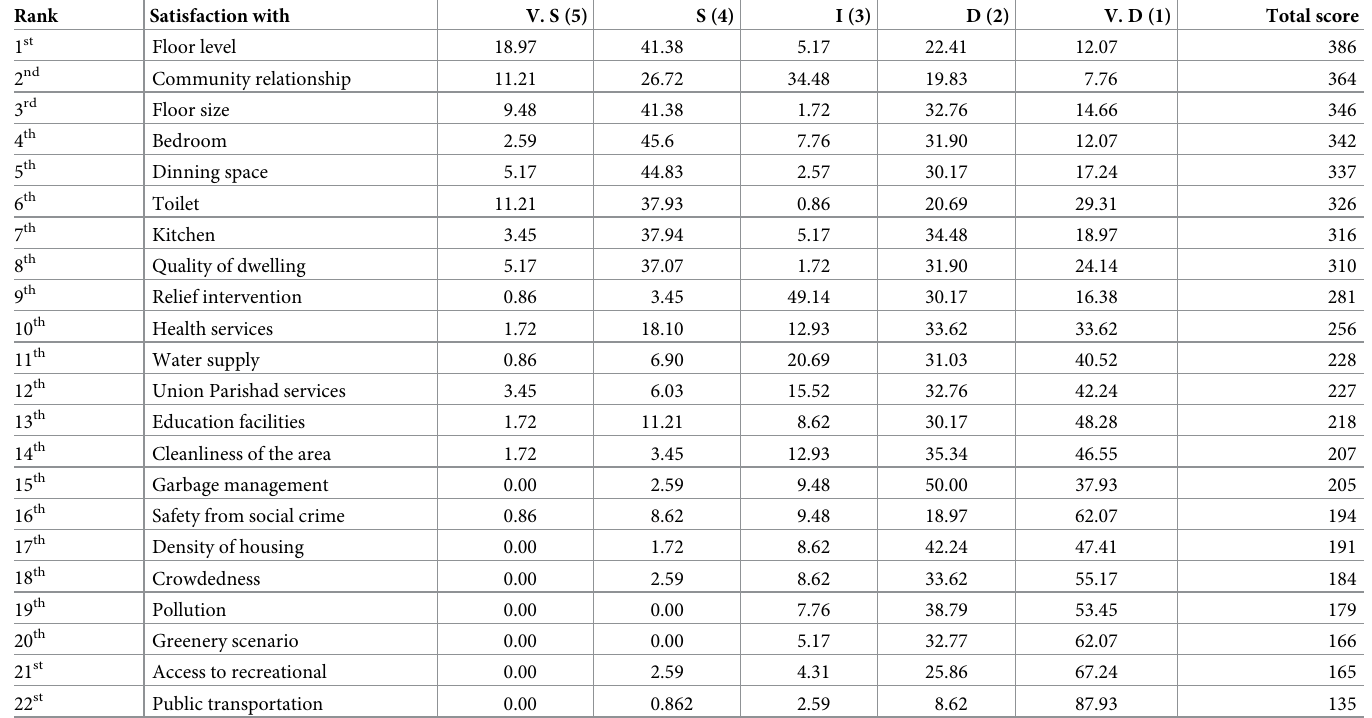
Table 4. Ranking of the residential satisfaction issues of the neighbouring communities (N = 116). Rank Satisfaction